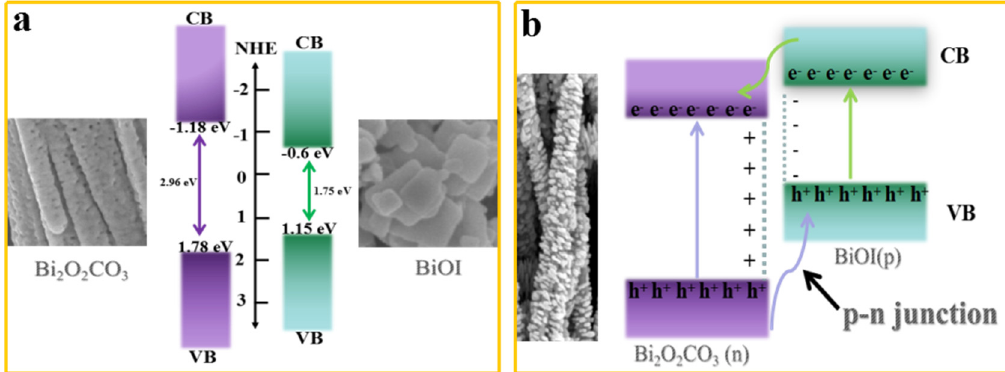
Figure 10. Schematic diagram for ( a ) energy band of Bi 2 O 2 CO 3 and BiOI, ( b ) the formation of the p-n junction and the possible charge separation.